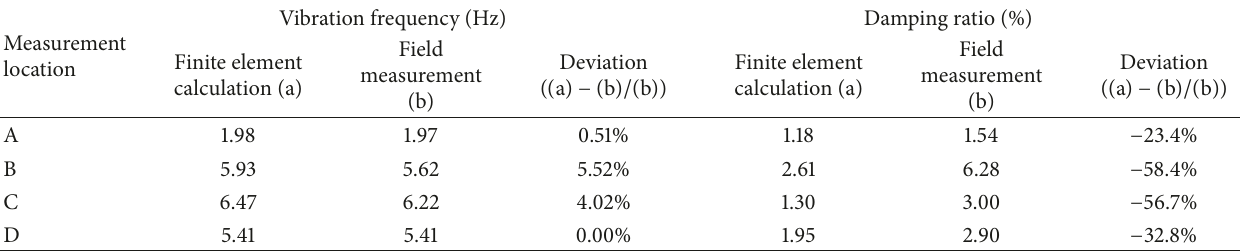
Table 6: Comparison of vibration characteristics from the finite element analysis and field measurements.